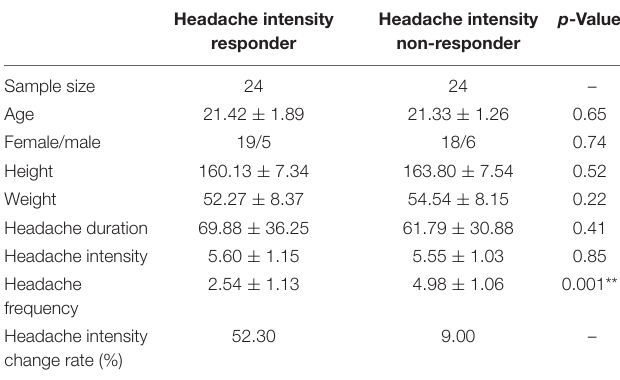
Table 4 ). Among the significantly different FCs, 2 FCs